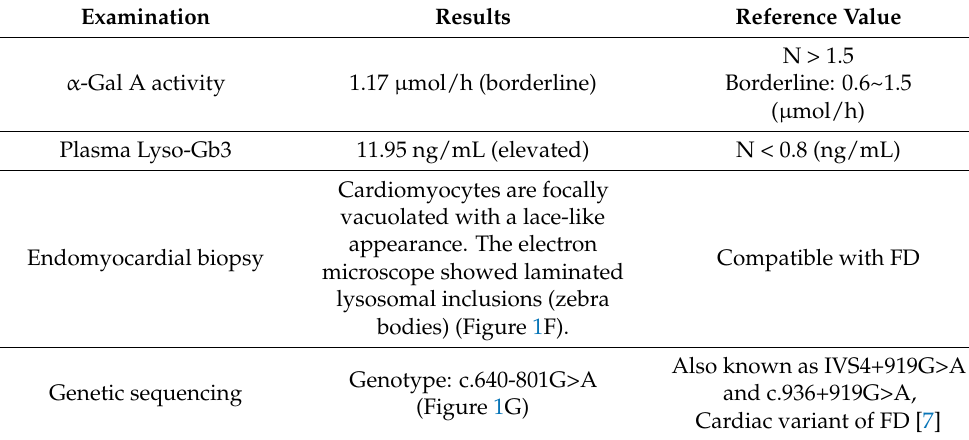
Table 2. Fabry disease